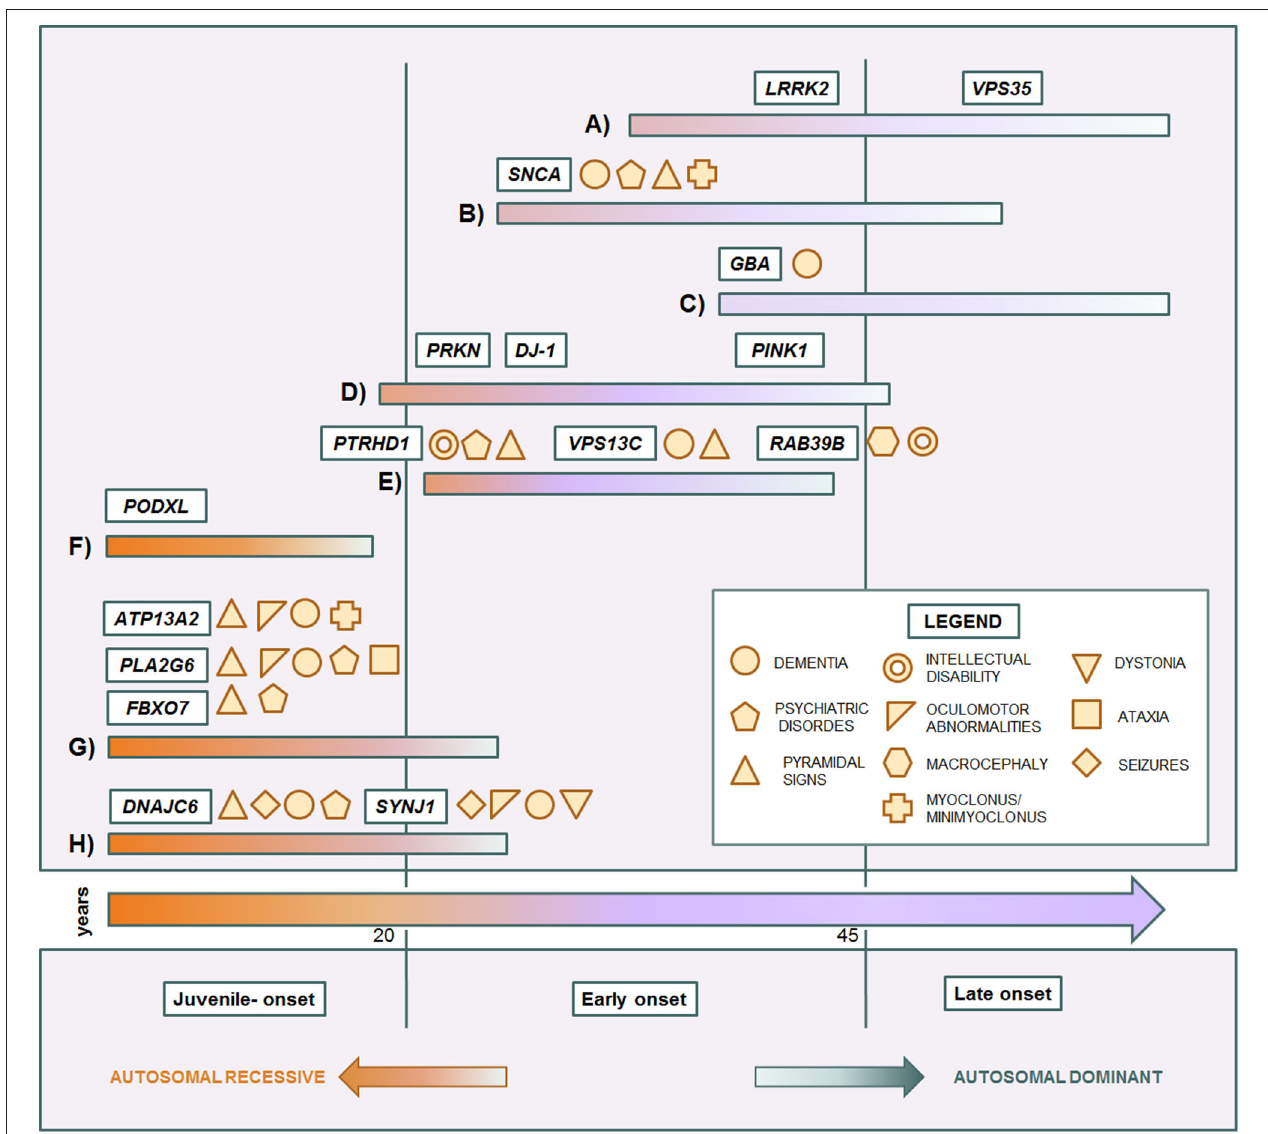
FIGURE 1 | Genotype-phenotype correlation in monogenic Parkinsonian conditions. Central arrow: time of onset. Each colored bar represents a subset of conditions. (A) iPD-like, late-onset autosomal dominant Parkinsonisms. (B) Complicated autosomal dominant Parkinsonisms. (C) Genetic risk factor causing late-onset Parkinsonism. (D) Typical autosomal recessive early-onset Parkinsonisms. (E) Complicated autosomal recessive early onset Parkinsonisms. (F) Juvenile uncomplicated Parkinsonism. (G) Juvenile pallido-pyramidal syndromes. (H) Juvenile atypical Parkinsonisms.